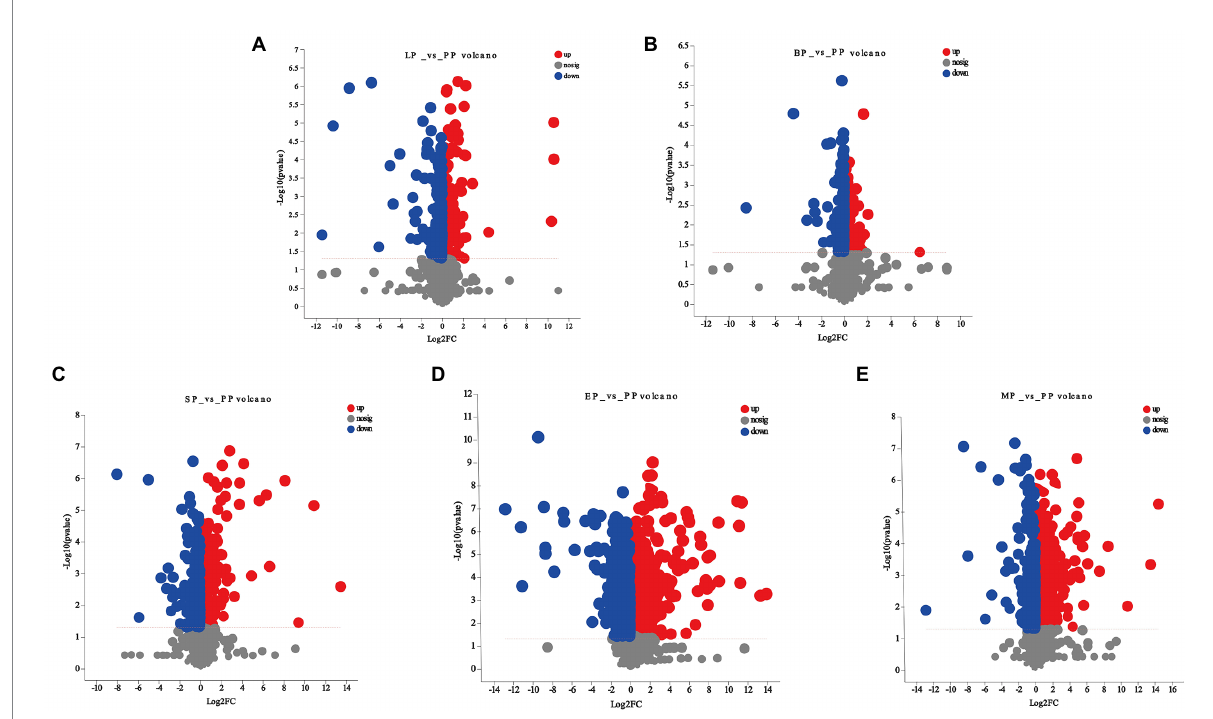
FIGURE 4 Volcano plot for significant differentially expressed metabolites of (A) LP vs. PP; (B) BP vs. PP; (C) SP vs. PP; (D) EP vs. PP; (E) MP vs.